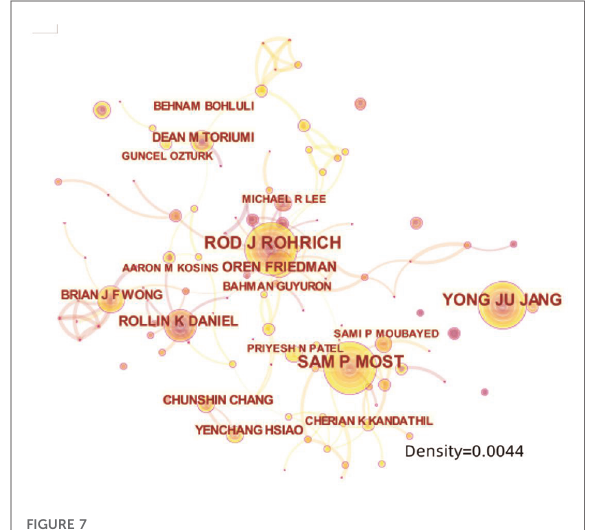
FIGURE 7 The network map of most productive authors.